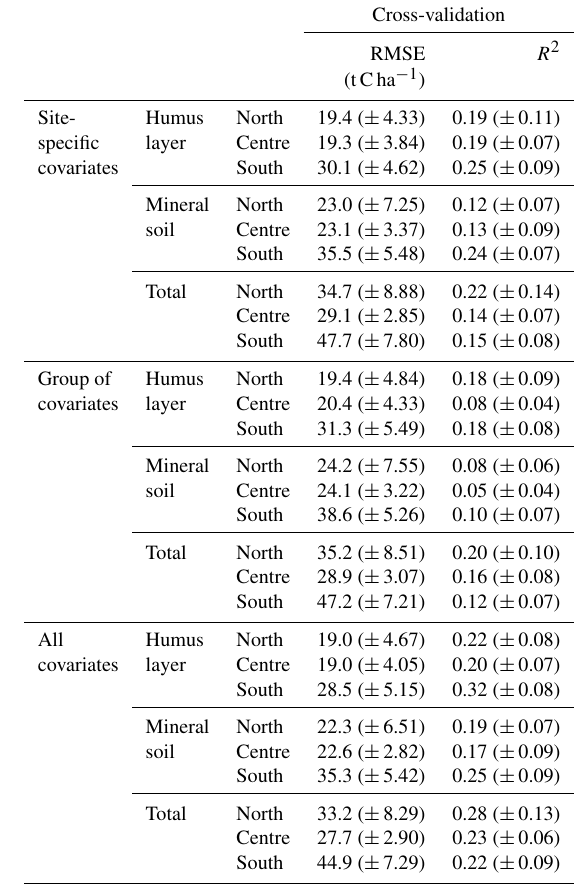
Table 4. Cross-validation of the local random forest